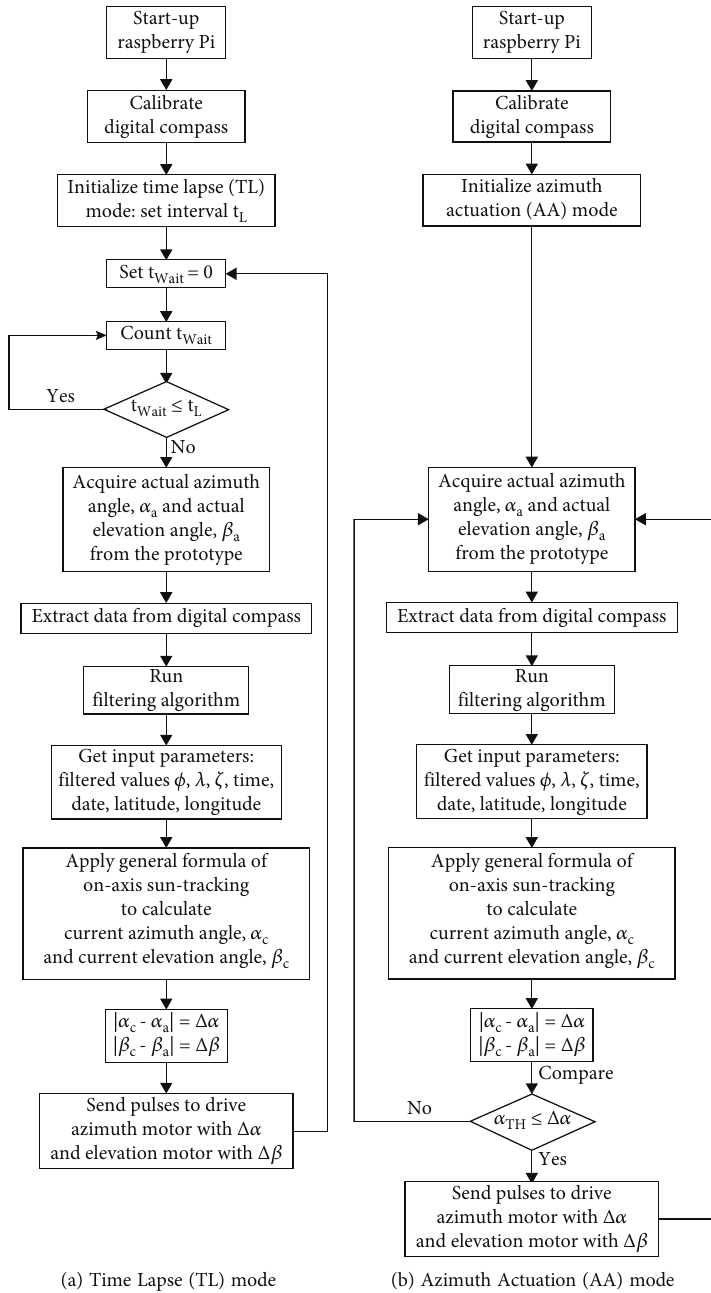
Figure 5: Flow charts for time lapse (TL) and azimuth actuation (AA)